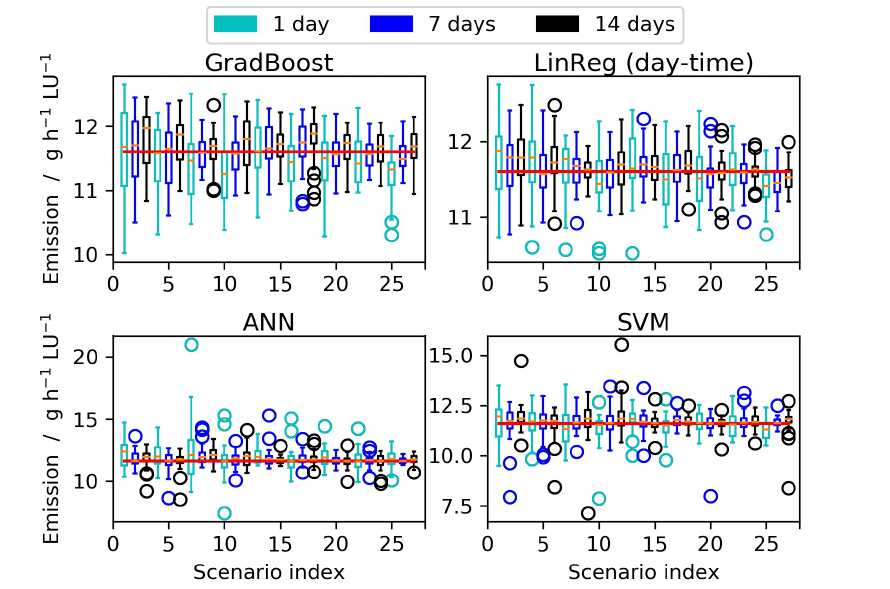
Figure 6. Averaged emissions [g h − 1 LU − 1 ] predicted by gradient boosting, multilinear regression with reduced number of input features, a hyperparameter-tuned artificial neural network and support vector regression. The box plots show the mean values and the variabilities based on 30 random realizations of each scenario, where the associated length of the measurement period in the scenario is indicated by the colors cyan (1 day), blue (7 days) and black (14 days). For comparison the mean observed emission value (11.6 g h − 1 LU − 1 , calculated from the full experimental dataset) is indicated by a red line. Please note that the y -axes have different